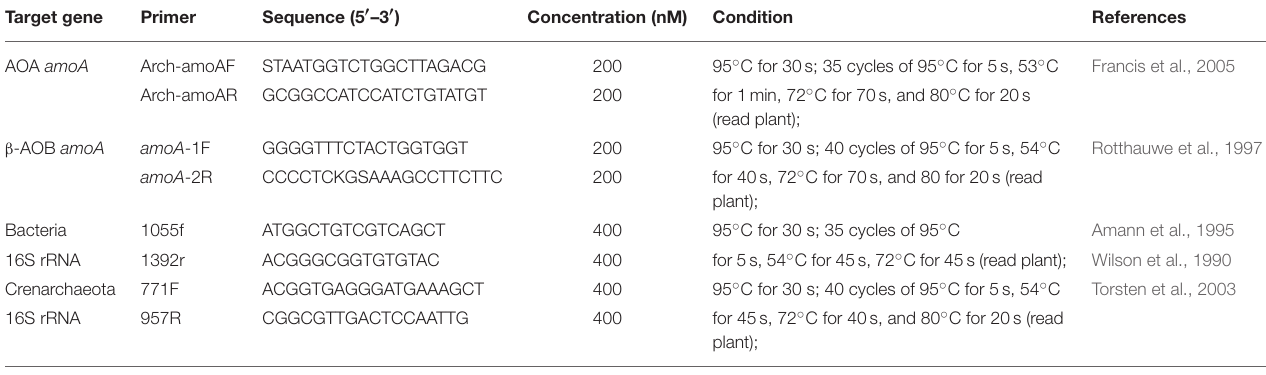
TABLE 1 | Primers used for PCR amplification for library construction and real-time PCR quantification. Target gene